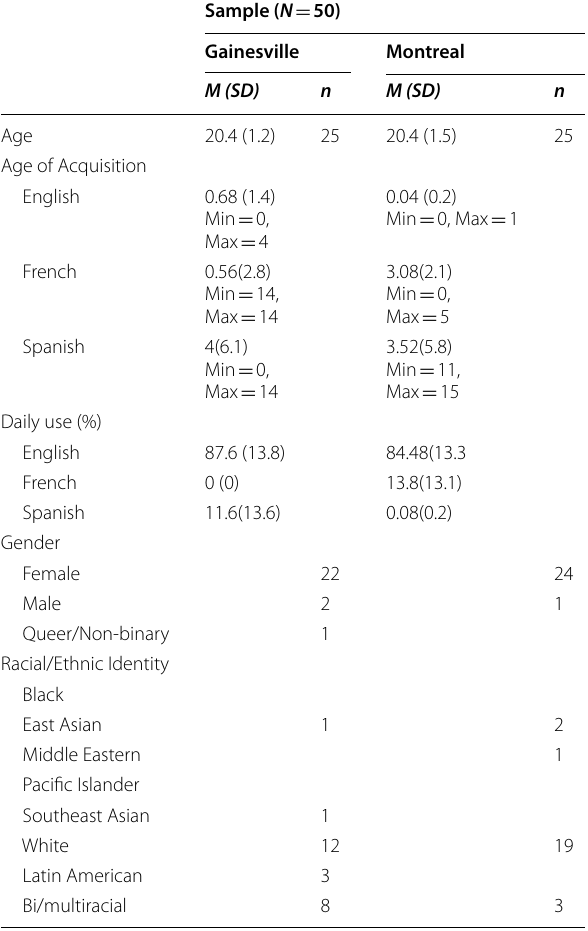
Table 1 Descriptive demographic background